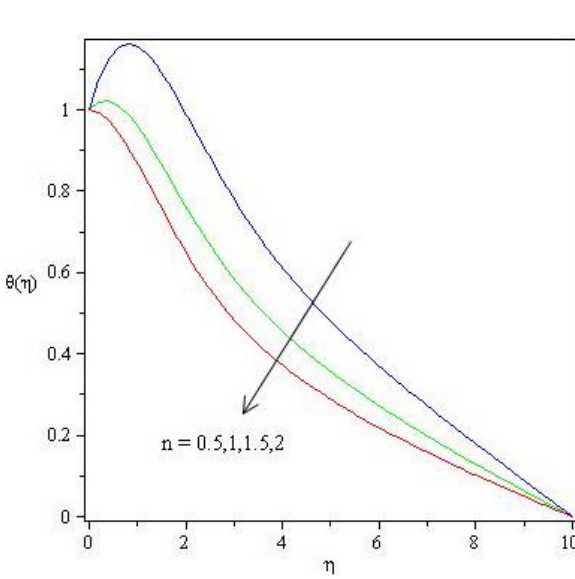
Fig. 16: Temperature profile for different values of Pr and M = 0, p = 1, n = 1.5, A = 0.5, B =